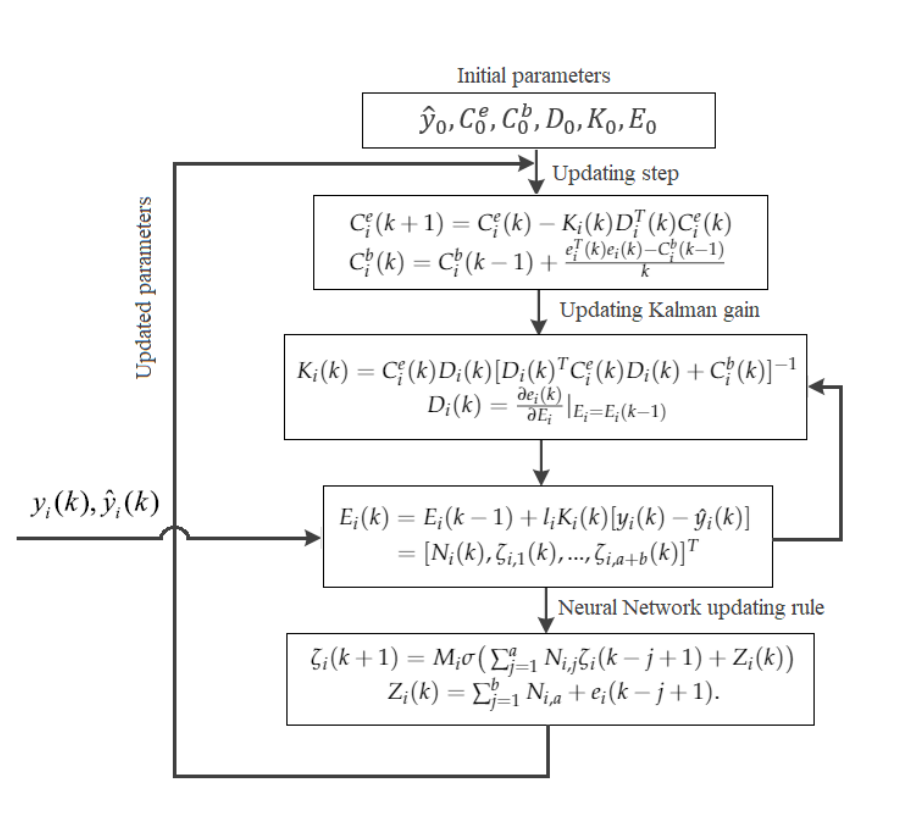
Figure 2. Flowchart of the proposed NN, EKF adaptive